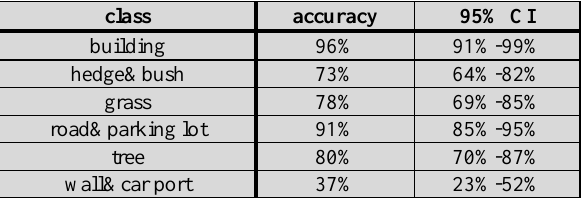
Table 11. User’s accuracy with CIs derived by cross validation (DT